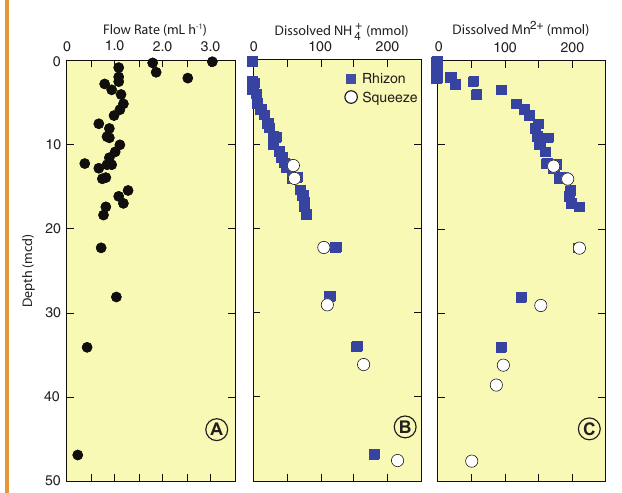
Figure 3. Downcore profiles of water sampling and analyses for the upper 50 m below seafloor on IODP Leg 302. [A] Fluid flow rate into Rhizon samplers averaged across examined sediment intervals. [B] Dissolved ammonium. [C] Dissolved